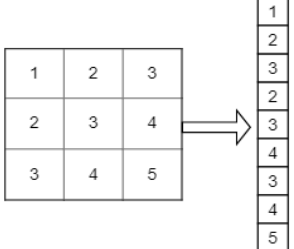
Figure 6. Flattening 2𝐷 feature maps to 1𝐷 vector.